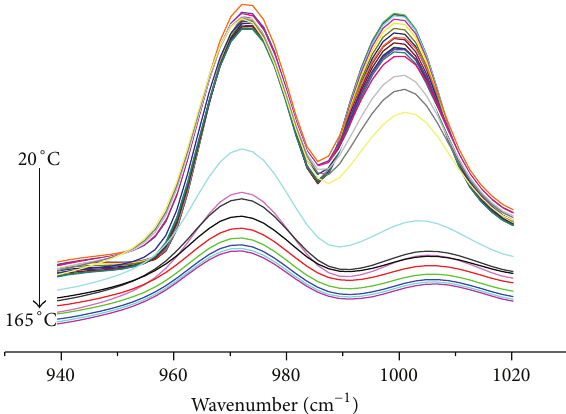
Figure 11: FTIR spectra of PP/PANI 4 at different temperatures (940–1020 cm −1